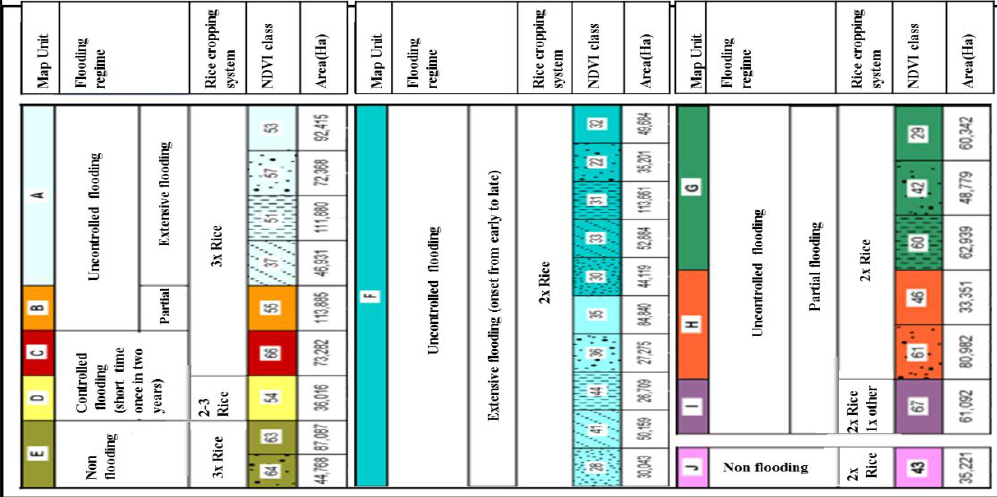
Figure 5. The detailed legend of the NDVI rice unit